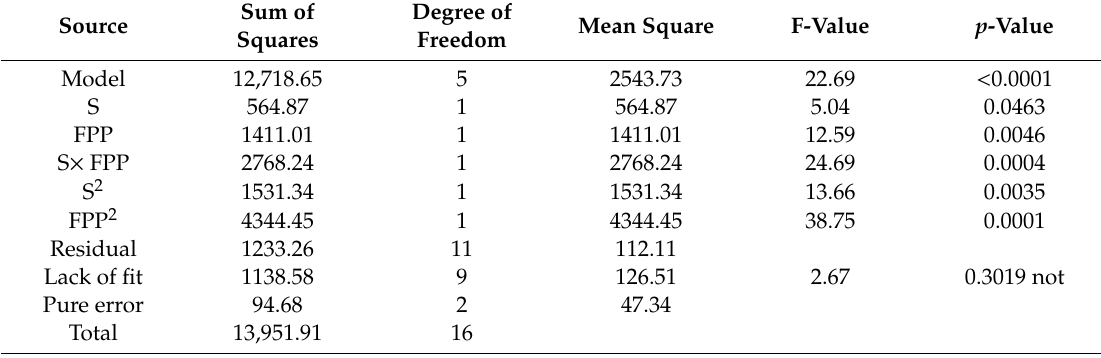
Table 6. ANOVA table for bottom kerf width.